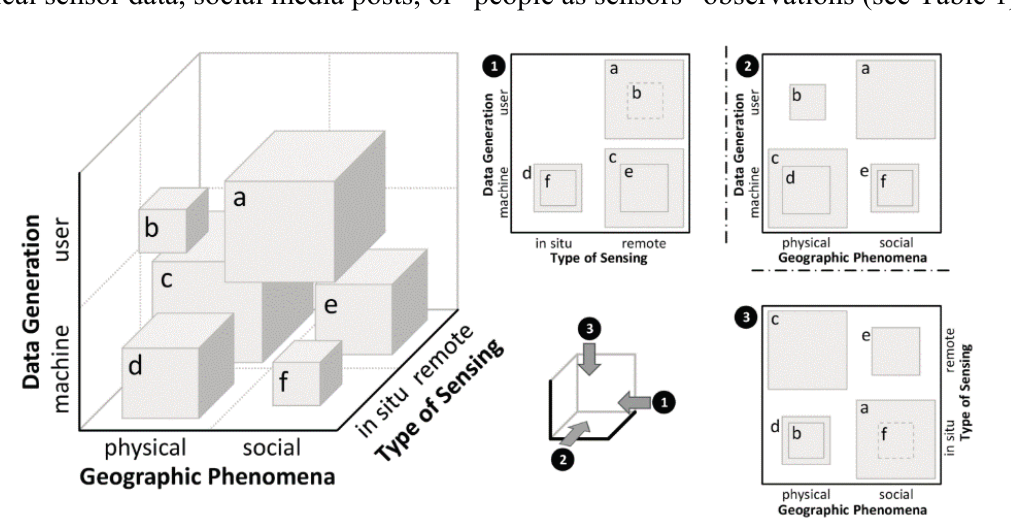
Figure 2. Dimensions involved in sensing (data generation, geographic phenomena, type of sensing), and some exemplary blocks ( a – f ) representing the amount of sensor data assigned to each dimension [140]. ( a ) VGI and mobile network traffic: associated with in situ sensing, social phenomena, and user-generated data; ( b ) VGI in the context of environmental status updates: associated with in situ sensing, physical phenomena, and user-generated data; ( c ) Satellite imagery: associated with remote sensing, physical phenomena, and machine-generated data; ( d ) Measurements from sensors and sensor networks: associated with in situ sensing, physical phenomena, and machine-generated data; ( e ) Human settlements extracted from satellite imagery: associated with remote sensing, social phenomena, and machine-generated data; ( f ) Numerical data at entrances to, and exits from shopping malls, public transport, etc. : associated with in situ sensing, social phenomena (e.g., mobility), and machine-generated